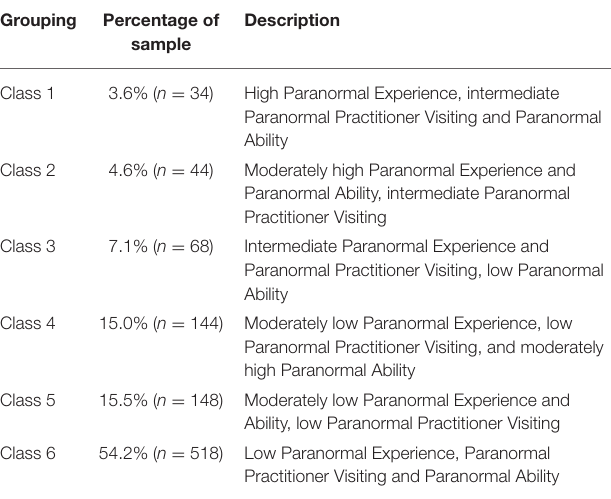
TABLE 3 | Profiles organised in sequence from higher to lower overall